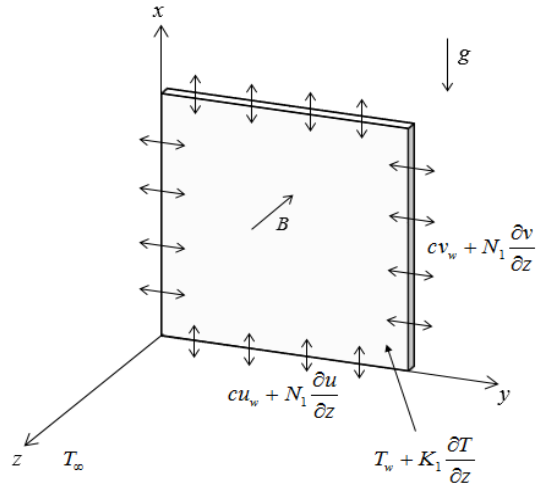
Figure 1. Physical model and coordinate system.